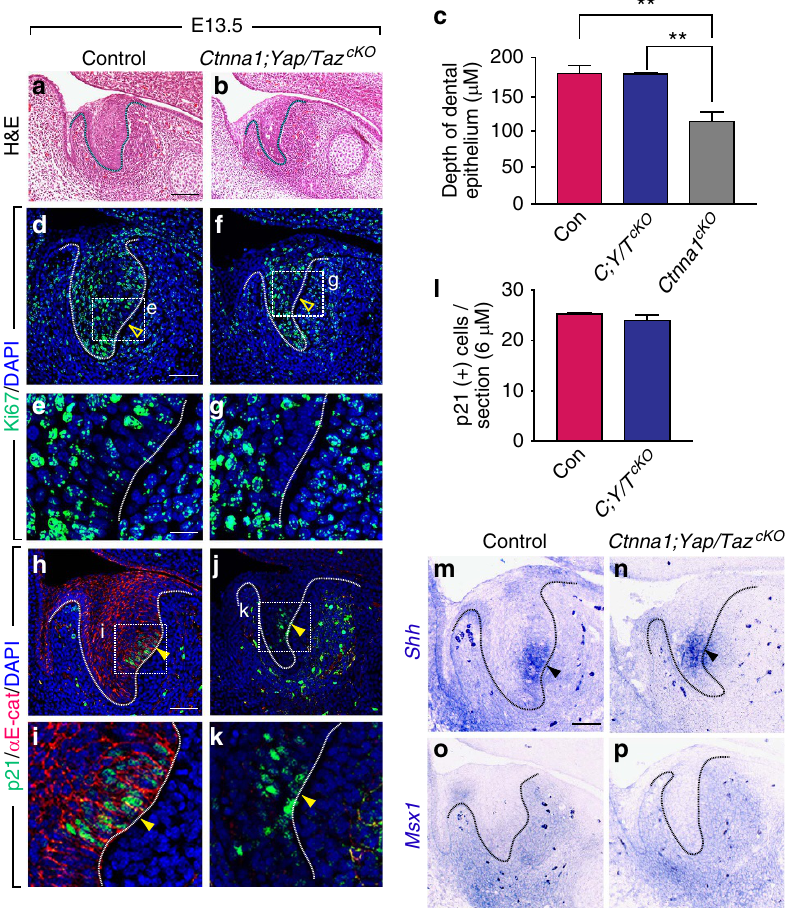
Figure 6 | a E-catenin regulates enamel knot formation and tooth germ invagination by controlling YAP/TAZ activity during tooth development. ( a , b ) H&E staining of E13.5 tooth germ shows that double deletion of Yap / Taz in the Ctnna1 cKO dental epithelium is able to rescue the invagination defect seen in Ctnna1 cKO . ( c ) Quantification of the depth of invaginated tooth germ in control, triple knockouts and Ctnna1 cKO at E13.5 (mean ± s.e.m., n ¼ 3, P o 0.01). ( d – g ) Deletion of Yap / Taz in Ctnna1 cKO restores the non-proliferating zone at the posterior region of the tooth germ, as assessed by Ki67 staining, indicating the formation of the EK (open yellow arrowheads). ( h – k ) p21 staining confirms that deletion of Yap / Taz in Ctnna1 cKO reestablishes a non- proliferating zone, indicating the formation of the EK in the tooth germ (yellow arrowheads). ( l ) Quantification of the number of p21-positive cells per section in control and triple knockout tooth germs (mean ± s.e.m., n ¼ 3, P 4 0.05). ( m , n ) Shh expression at the posterior region of the tooth germ epithelium is rescued on Yap/Taz deletion in the Ctnna1 cKO (dark arrowheads). ( o , p ) Expression of the mesenchymal gene, Msx1, is rescued in the dental mesenchyme at E13.5 after deletion of Yap / Taz in Ctnna1 cKO in the tooth germ. All quantifications are analysed by using Student’s t -test. * P o 0.05, ** P o 0.01. Dotted lines outline the epithelium of the incisor tooth germ. Scale bar, 100 m m ( a , b ); 50 m m ( d , f , h , j , m – p ); 8 m m ( e , g , i , k